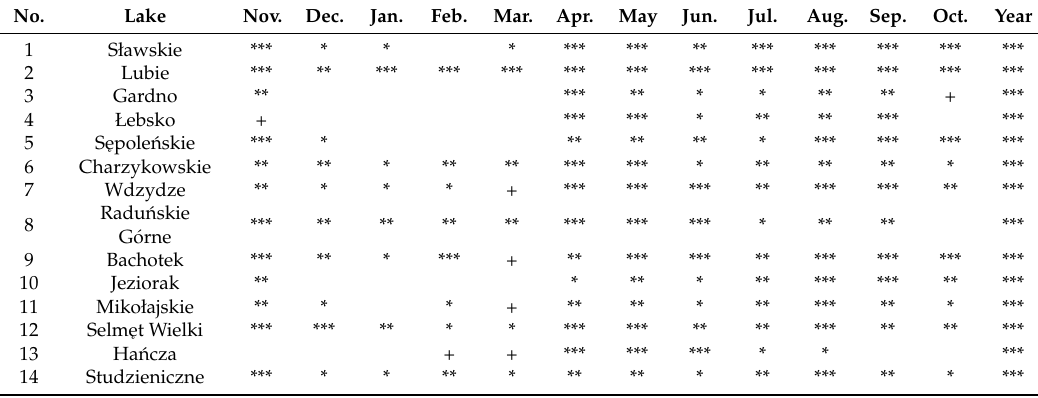
Table 2. Results of the analysis of annual and monthly trends of water temperatures in lakes. No.